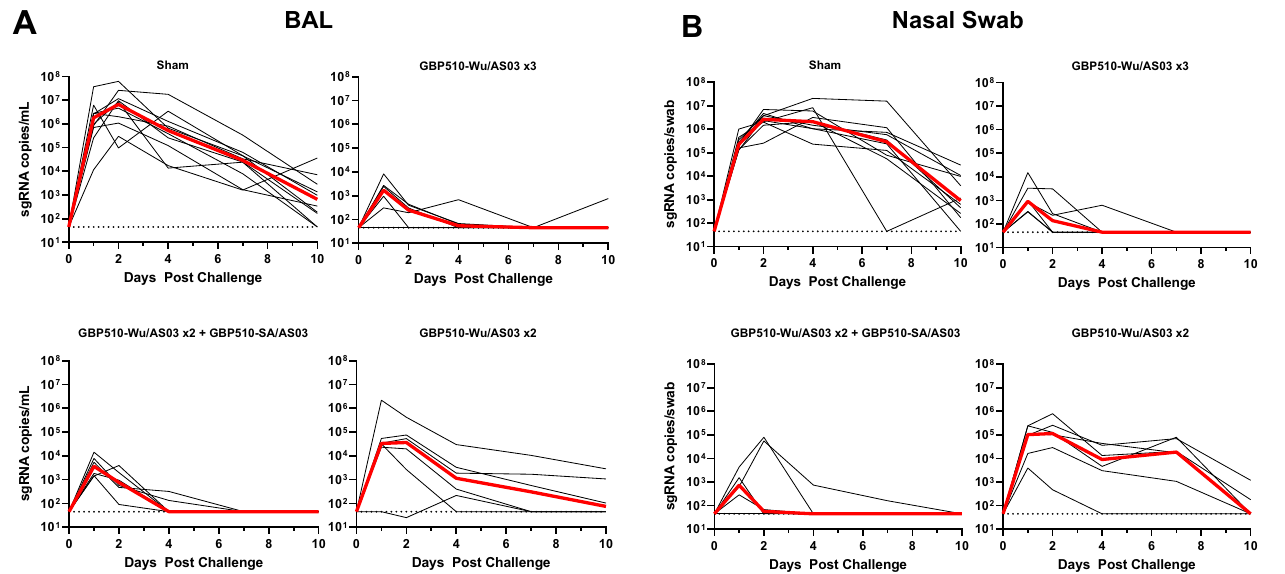
Fig. 4 Viral loads following challenge with delta SARS-CoV-2. Group 1 received three sham doses, Group 2 received three doses of GBP510- Wu, Group 3 received two doses of GBP510-Wu and one dose of GBP510-SA, and Group 4 received two doses of GBH510-Wu and one sham dose. A Subgenomic RNA (sgRNA) copies/mL in the bronchoalveolar lavage (BAL) following Delta SARS-CoV-2 challenge days 0 to 10. Medians are shown with red lines. B Subgenomic RNA (sgRNA) copies/swab in the nasal swabs (NS) following Delta SARS-CoV-2 challenge days 0 to 10. Medians are shown with red